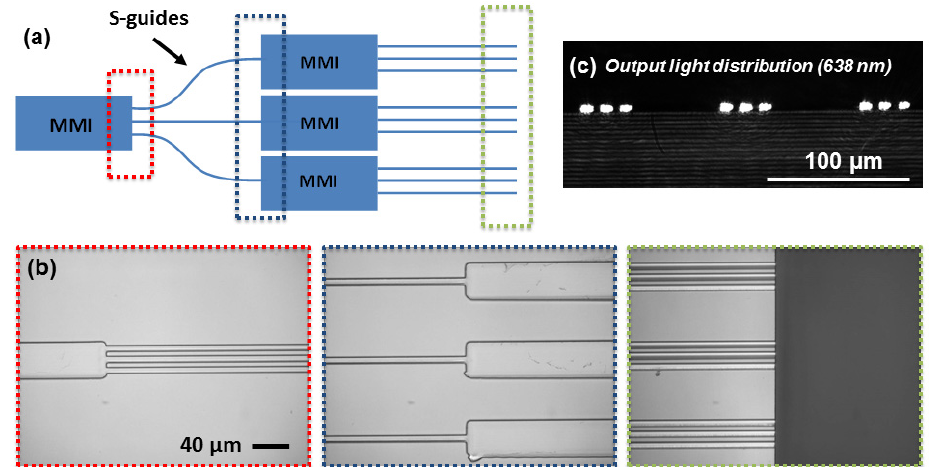
Figure 10. ( a ) Overview of the photonic device composed of 4 MMI couplers (1 × 3): one source can monitor 9 waveguides. ( b ) Microscopic images of the device, showing the end of the first MMI coupler (left), the transition from waveguides to 3 MMI couplers (center), and the 9 output waveguides (right). ( c ) Corresponding output light distribution under excitation at 638 nm.